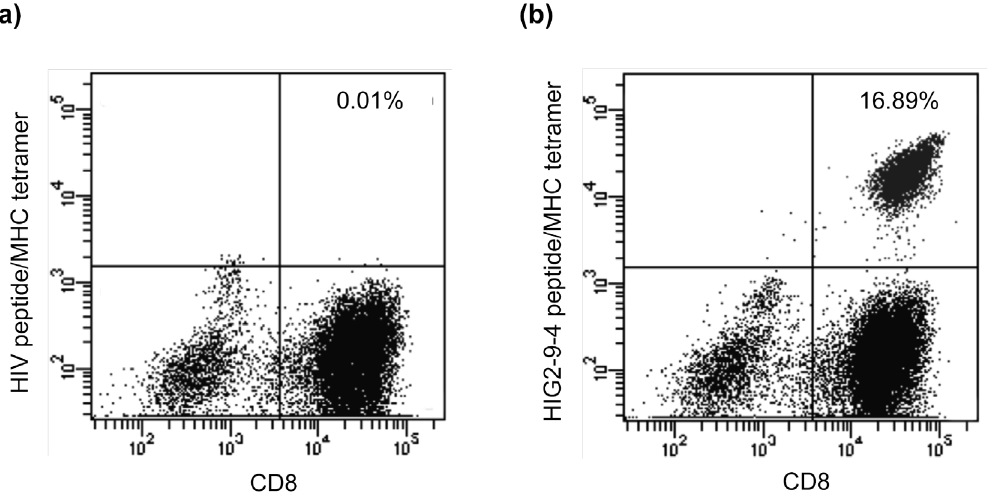
Figure 2. The expression of a HIG2-9-4 peptide-specific T cell receptor on CD8 + T cells. The expression of the HIG2-9-4 peptide-specific T cell receptor was examined on CD3 + CD4 2 cells following CTL expansion culture of HIG2-9-4 peptide-induced CTLs. (a) A quadrant gate was set based on the staining results with the HIV peptide/HLA-A*02: 01 tetramer. (b) CD8 + T cells expressing the HIG2-9-4 peptide/HLA-A*02: 01-specific T cell receptor were detected. Similar results were obtained from three independent experiments.